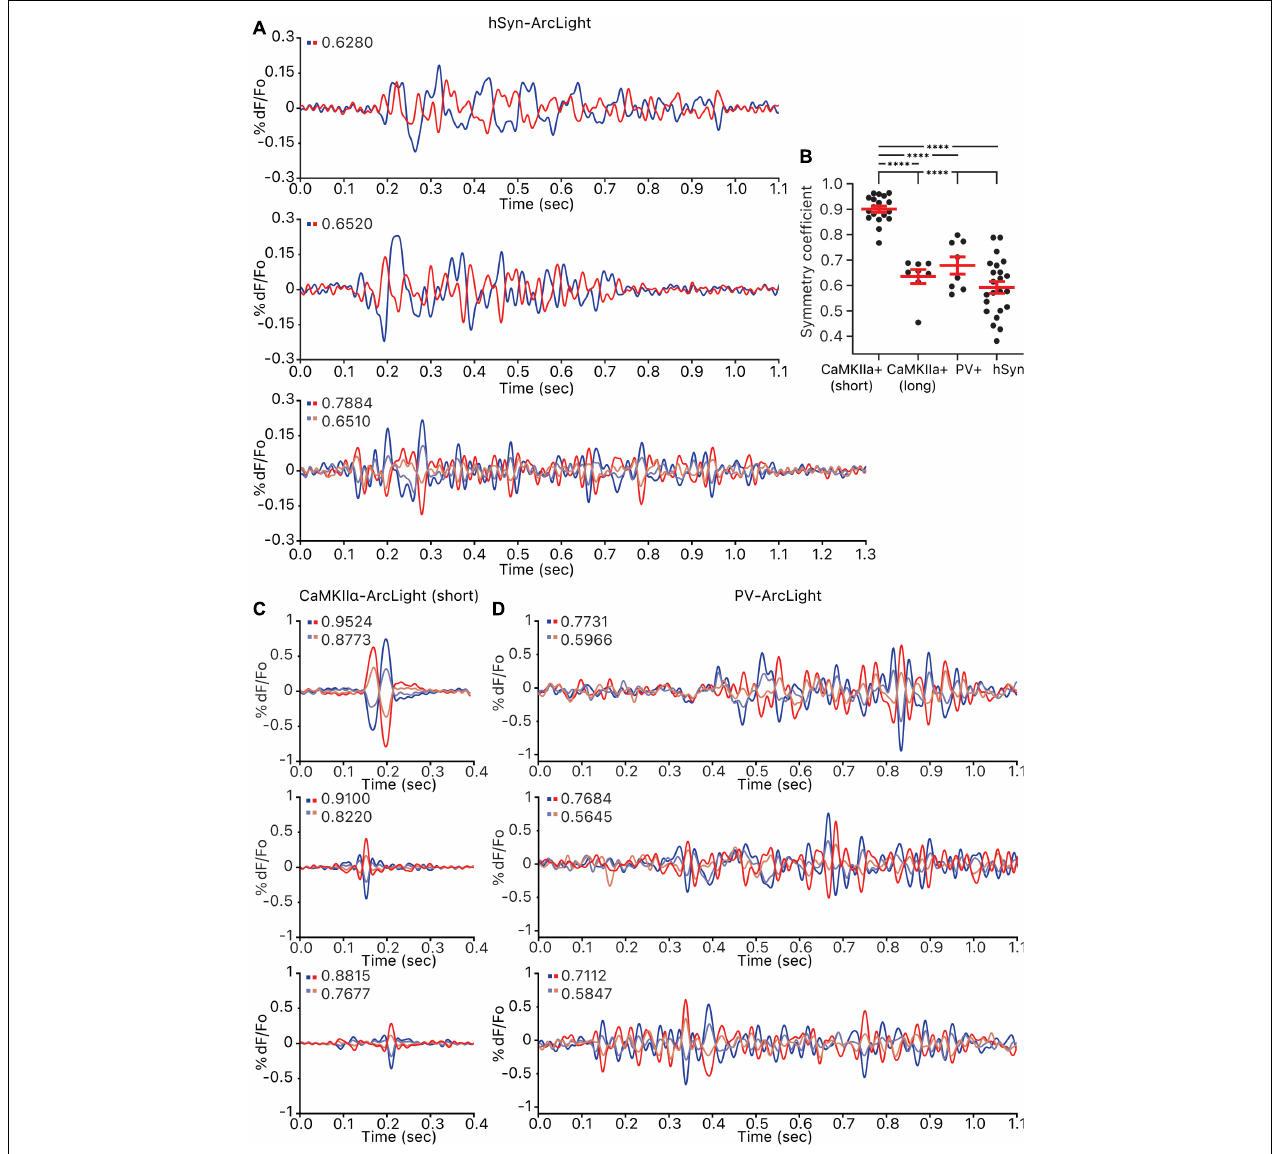
FIGURE 4 | Symmetry of the oscillations observed in all cells, CaMKII α + cells, and PV+ cells. For each oscillation, pixels were ordered by their correlation strength to the reference pixel and grouped into 5–7 groups. Groups of the same size that are the most inversely correlated to one another were paired off, and the amplitude symmetry coefficient for each pair is calculated and shown on the top left of each axis. (A) Three example hSyn-ArcLight oscillations. The number of pixels in each group per pair is as follows: from the top, 1,045, 970, 1,051 and 1,051. (B) Amplitude symmetry coefficients of all pairs from all oscillations. ∗∗∗∗ p < 0.0001 for one-way ANOVA and Tukey’s multiple comparisons test. (C) Three example CaMKII α -ArcLight (short) oscillations. The number of pixels in each group per pair is as follows: from the top, 945 and 945, 945 and 945, 1,018 and 1,018. (D) Three example PV-ArcLight oscillations. The number of pixels in each group per pair is